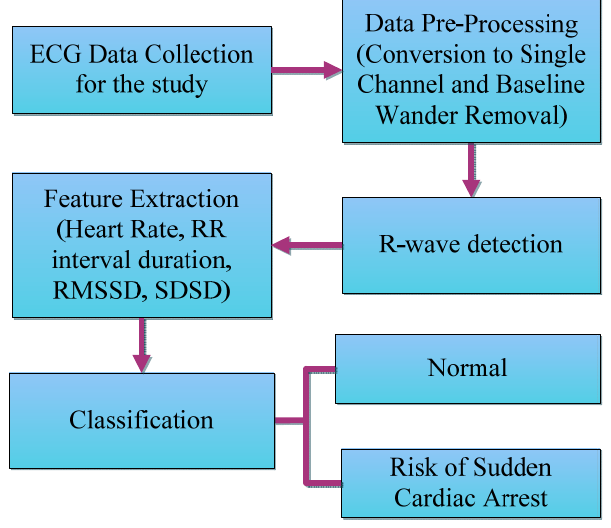
Figure 1. Block diagram of the methodology.